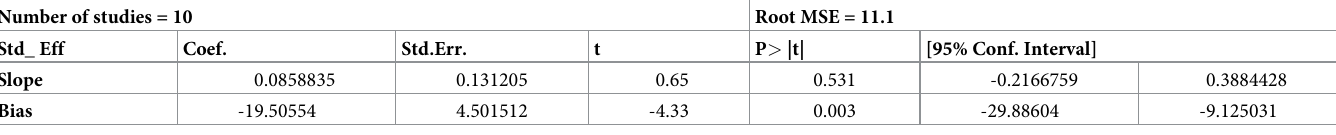
Table 2. Funnel plot (Egger’s test) for publication bias among hospitalized diarrheal patients. Number of studies = 10 Root MSE = 11.1 Std_ Eff Coef. Std.Err. t P > |t| [95% Conf. Interval] Slope Bias Test of HO = no small- study effects P =